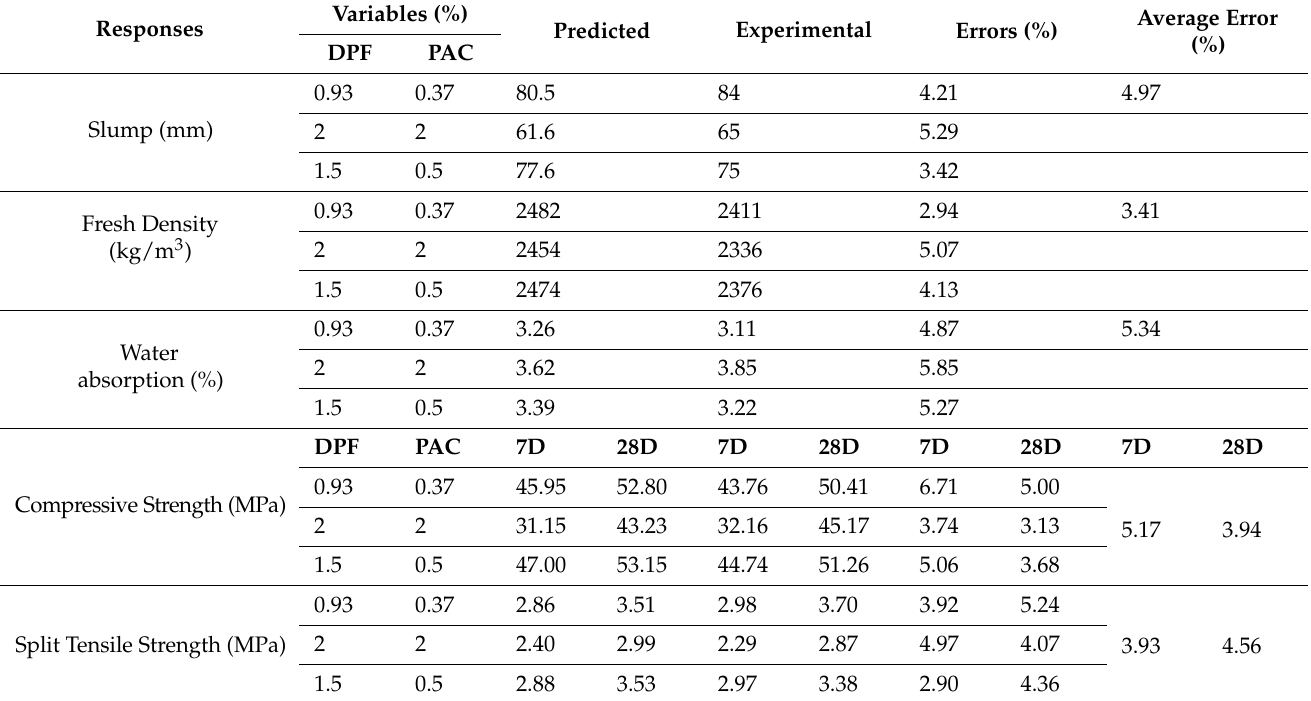
Table 13. Goals and results of multi-objective